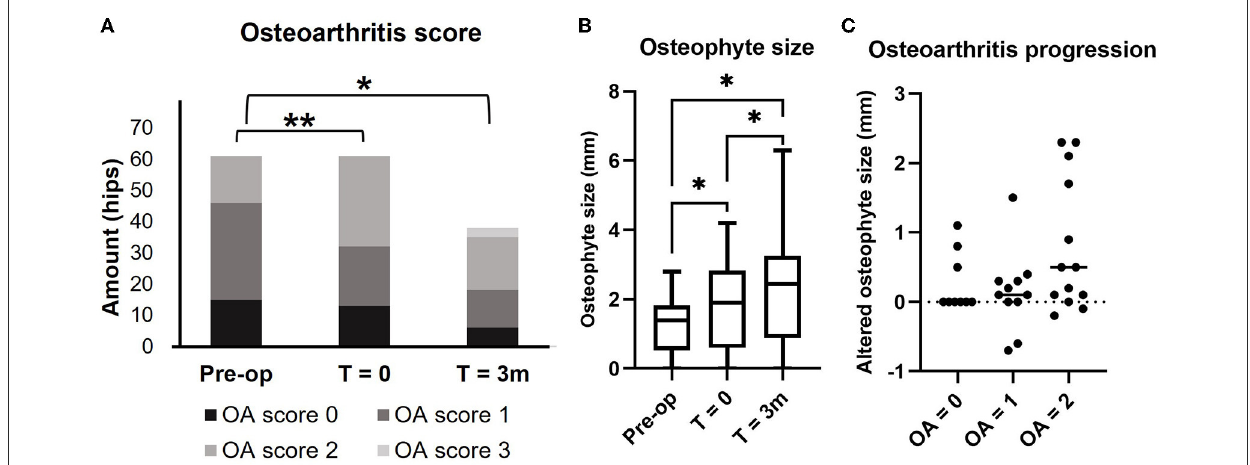
FIGURE3 Preoperative and postoperative osteoarthritis score (A) osteophyte size (B) , and comparison of osteophyte size growth between T = 0 (postoperatively) and T = 3 months (3m) grouped by OA score at the day of surgery (T = 0) (C) . Osteoarthritis score and osteophyte size were measured, respectively, on CT images of the hip joints, preoperatively at intake, T = 0 (postoperatively), and T = 3 months (3m). (A) Each bar represents the number of hips in each OA score at each time point. (B) Each bar represents the mean osteophyte size ± SD. (C) Each dot represents the changes of osteophyte size between T = 0 and T = 3m. * p -value of < 0.05 using the Bonferroni correction for multiple tests, ** p -value of < 0.05 using related samples for Friedman’s